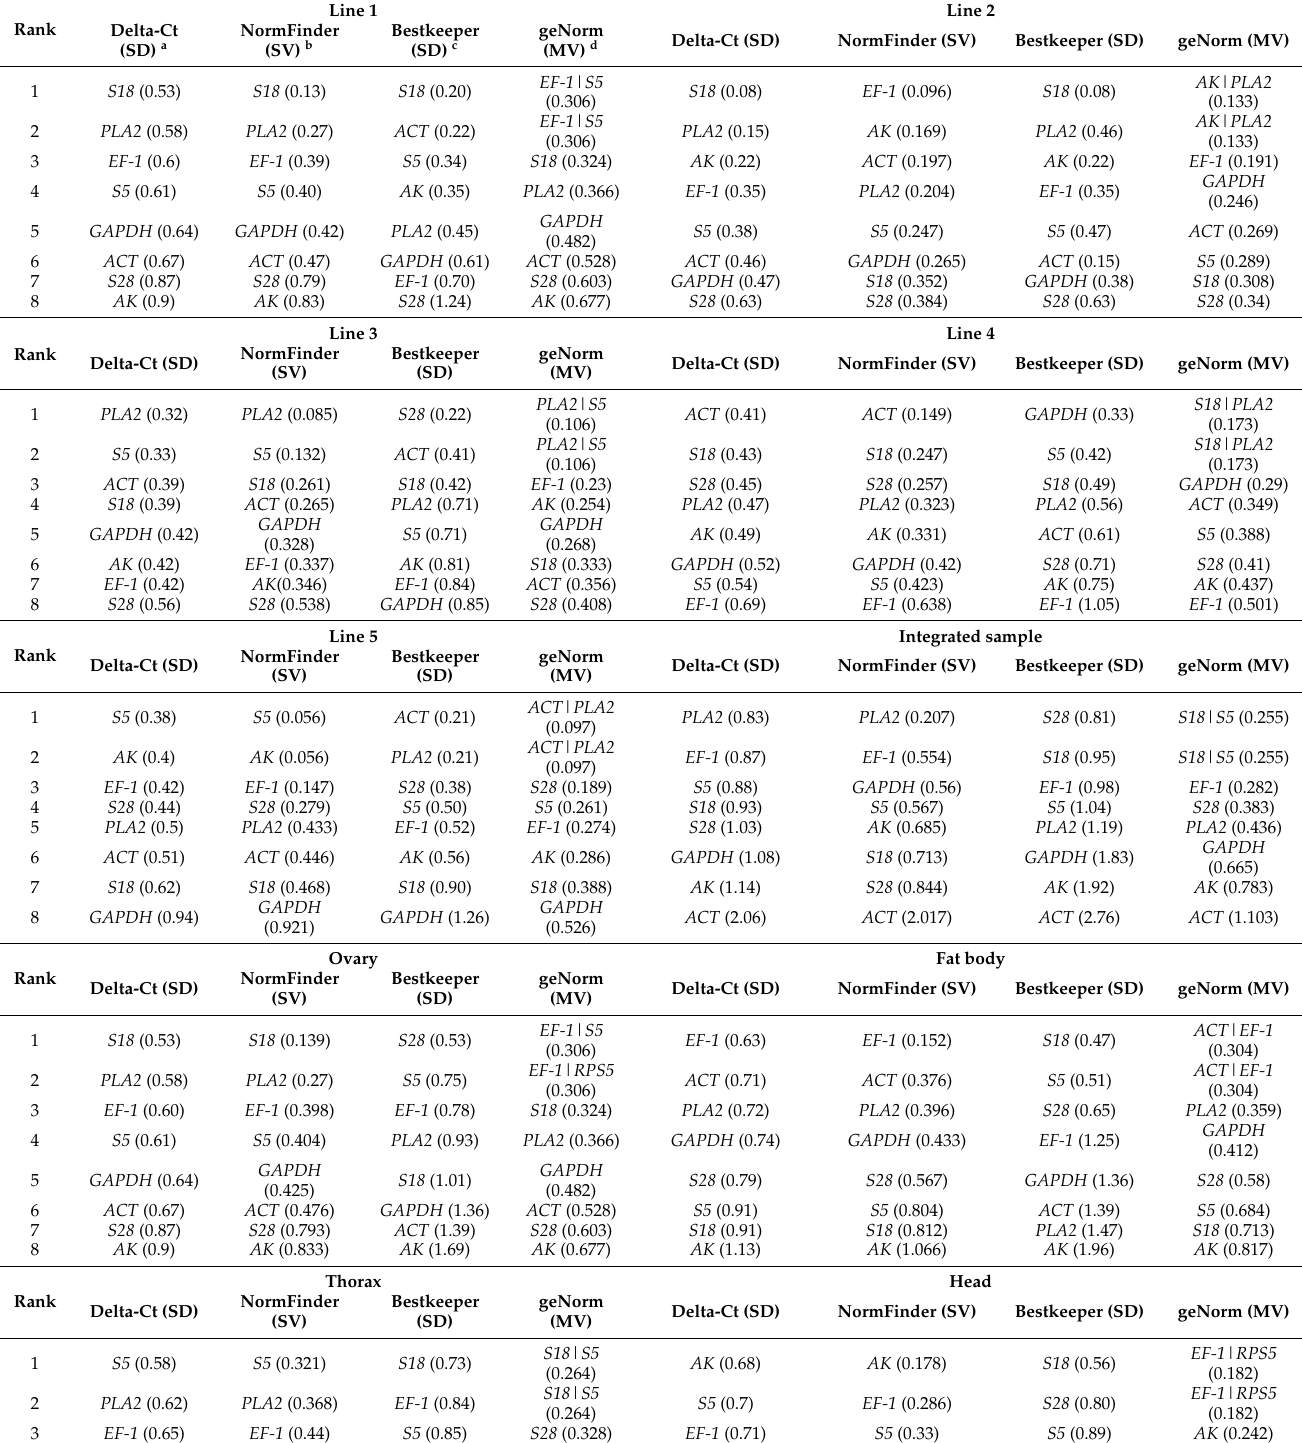
Table 2. Delta Ct (SD) a refers to the standard deviation, which is shown in Figure 1, and is a summary of the expression stability values of the eight genes analyzed by Ct distribution in NormFinder, BestKeeper, and geNorm. (SV) b denotes the stability values determined by NormFinder. The standard deviation of the Ct values was analyzed by BestKeeper and is indicated by (SD) c (SV) d denotes the stability values determined